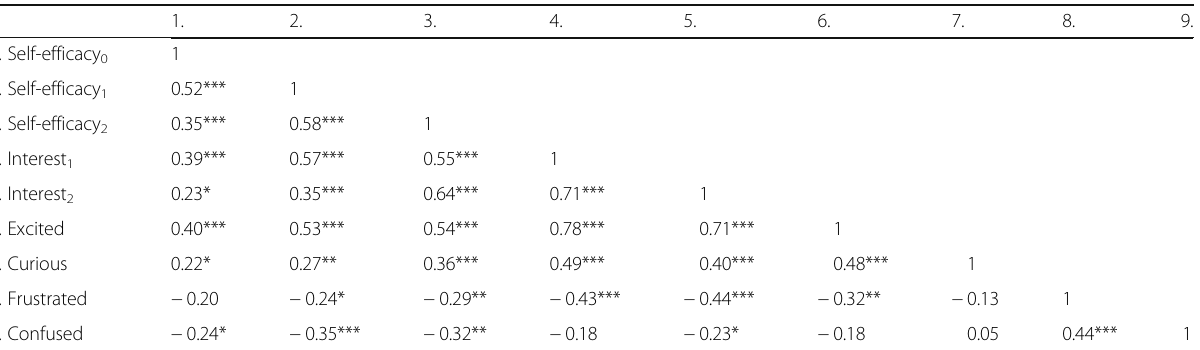
Table 3 Pearson ’ s correlations